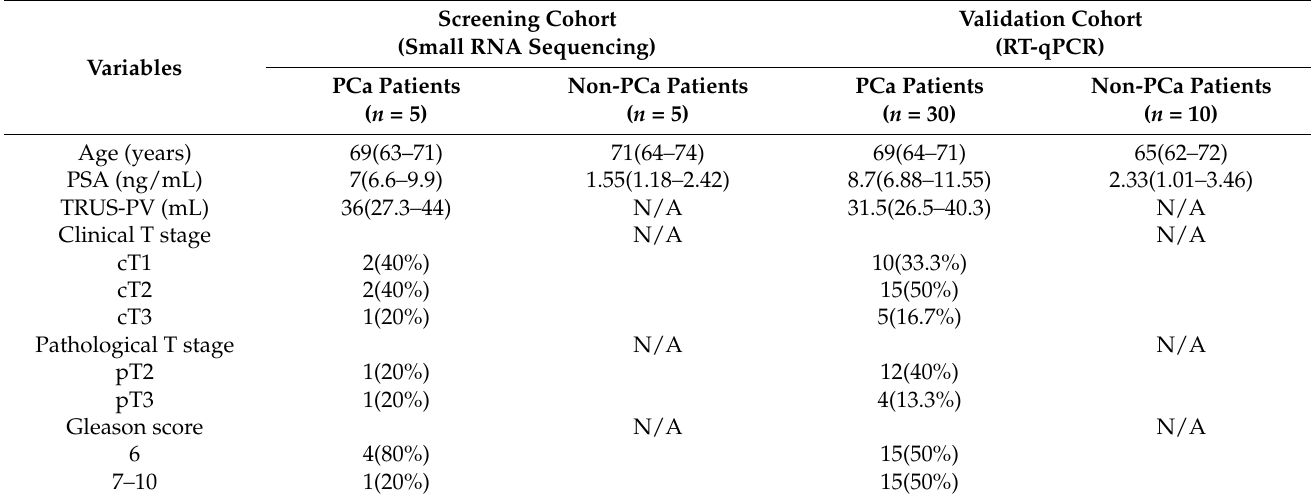
Table 1. Clinical characteristics of patients in the screening and validation cohort.